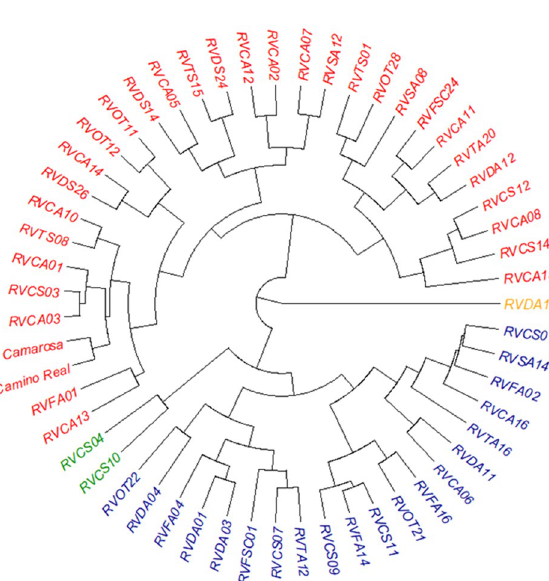
Figure 4. Dindex graphic for determining the best number of clusters in 53 selected genotypes and two controls of Fragaria × ananassa Dusch.